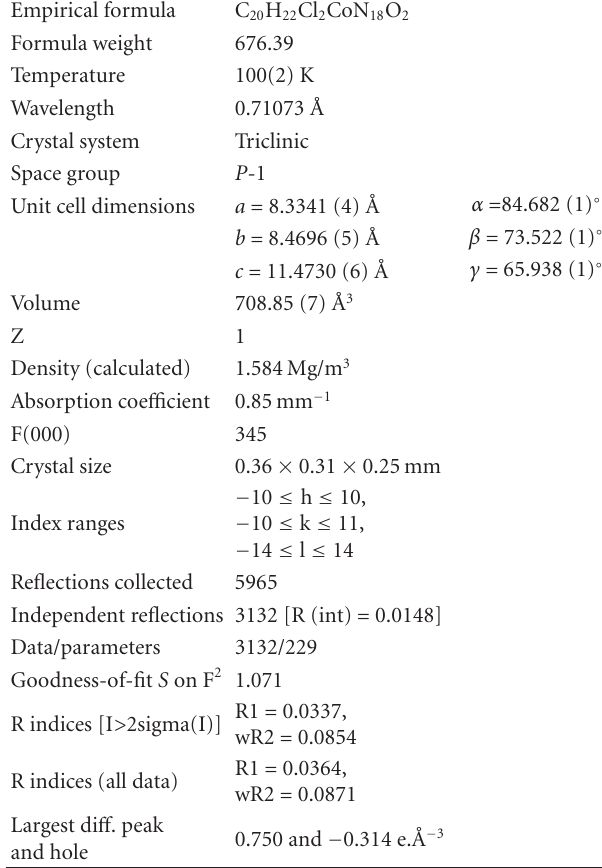
Table 1: Crystal data and structure refinement for 1